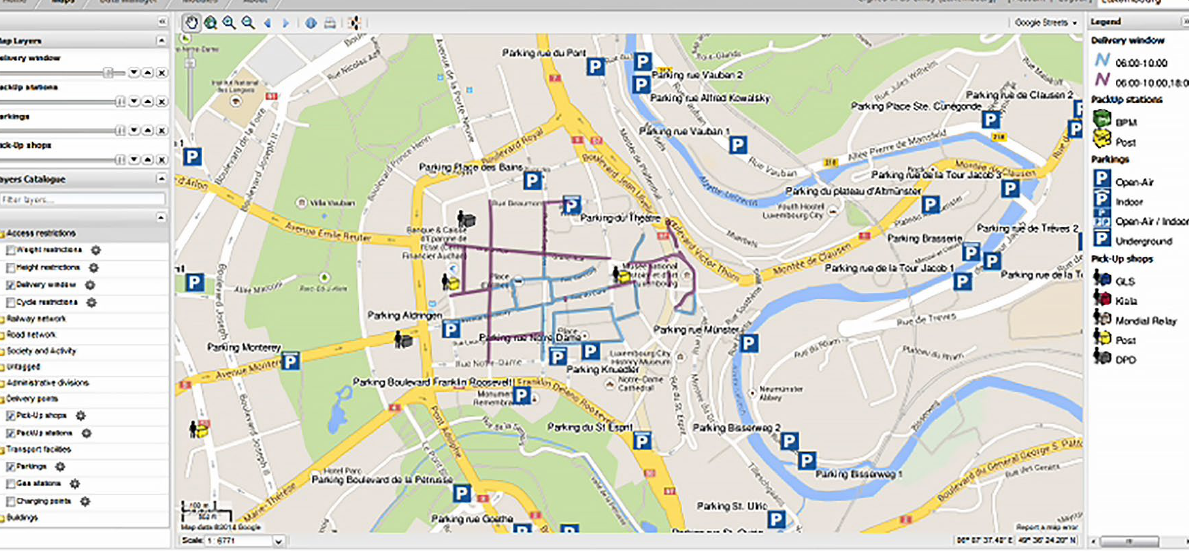
Figure 1. Screenshot from the Smart City Logistics platform (publicly accessible at: http://iguess-sl.list.lu )